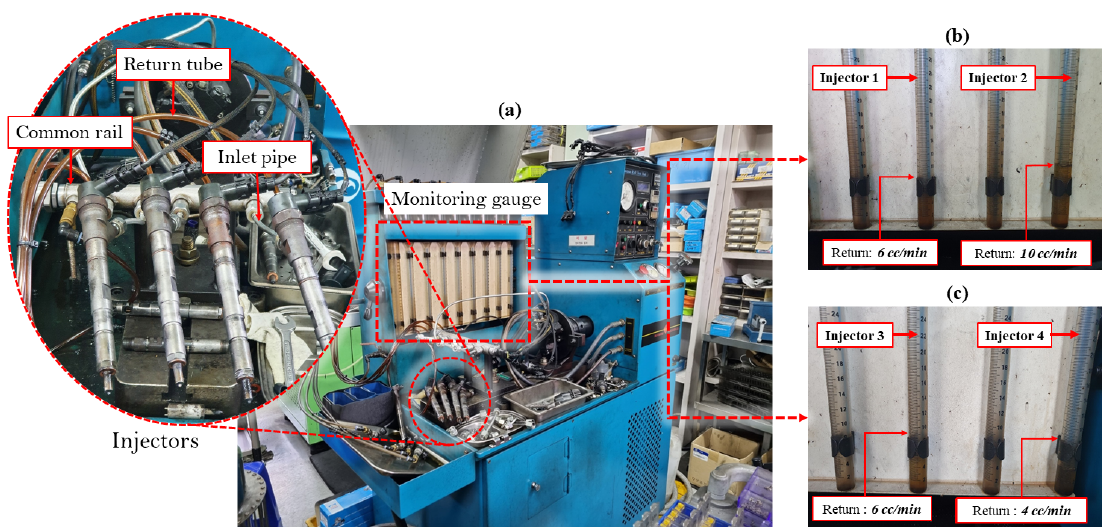
Figure 5. Back-leak test apparatus ( a ) and results ( b , c